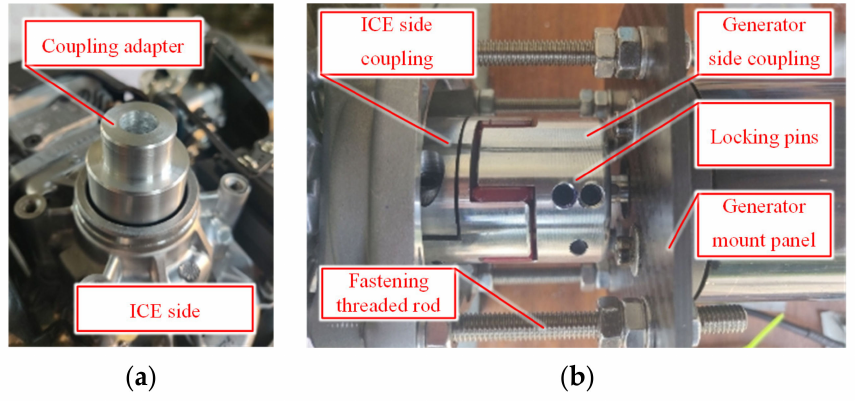
Figure 15. Coupling mechanical details: ( a ) Coupling adapter—ICE side, ( b ) ICE-EG coupling. Figure 16 represents the validation of the drive simulation model shown in Section 2.3.